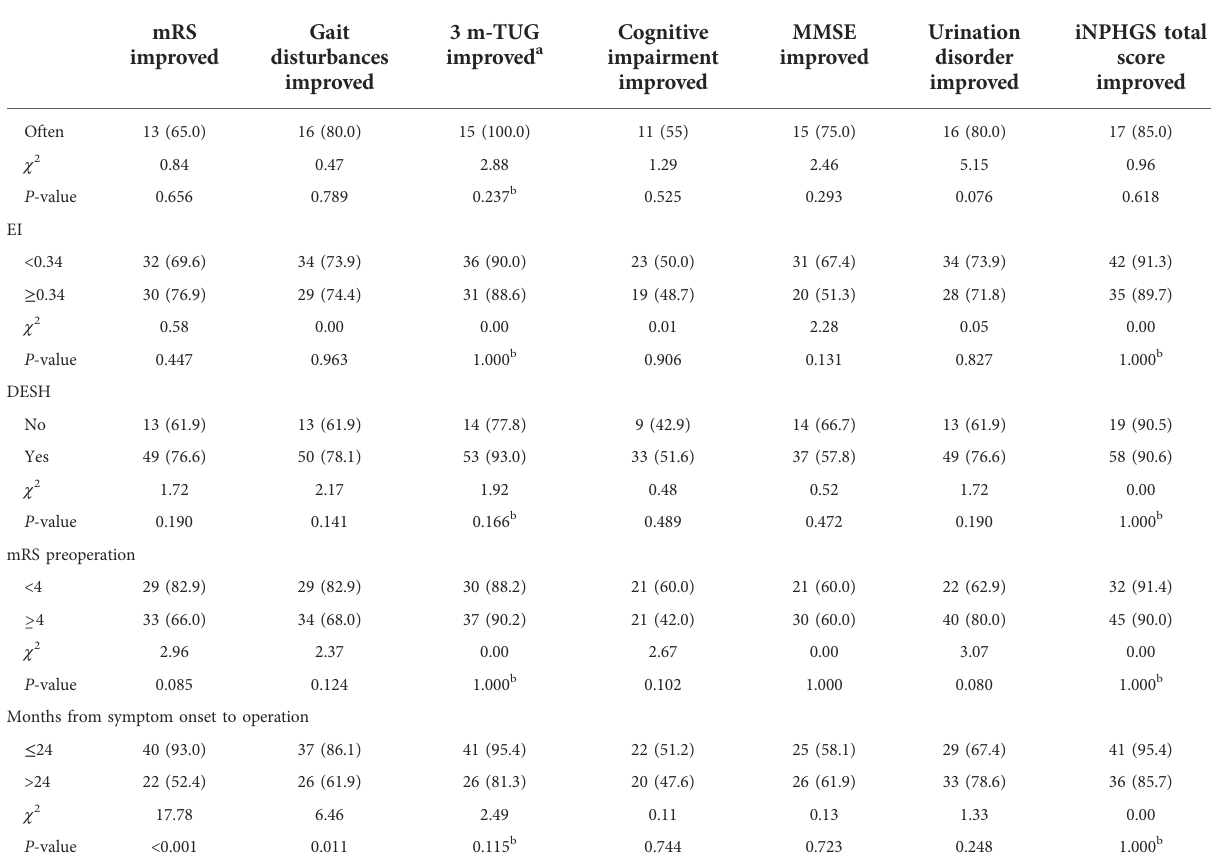
a n=75. b Tested by using the continuity adjusted Chi-square test. c Tested by using Fisher ’ s exact test. The differences between groups were tested by using the Chi-square